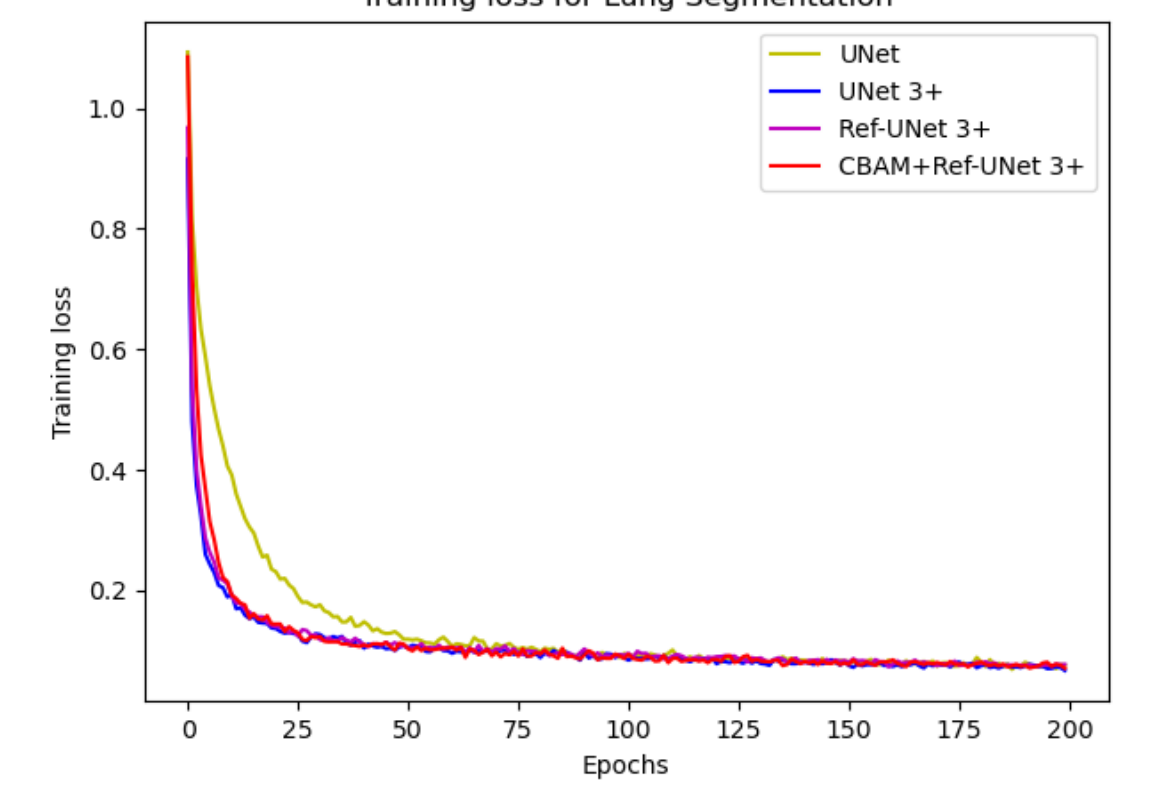
Figure 8. Training loss of the proposed models against UNet and UNet 3 +.